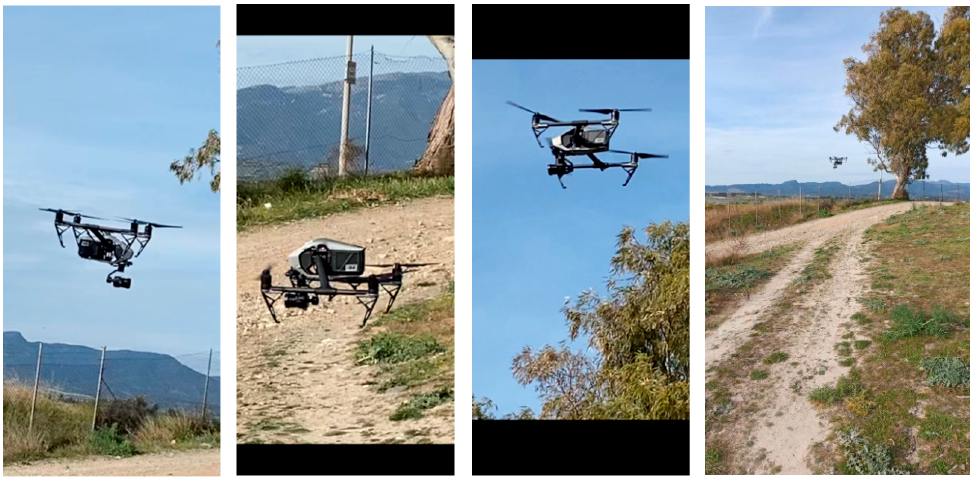
Figure 10. The drone during the open-field